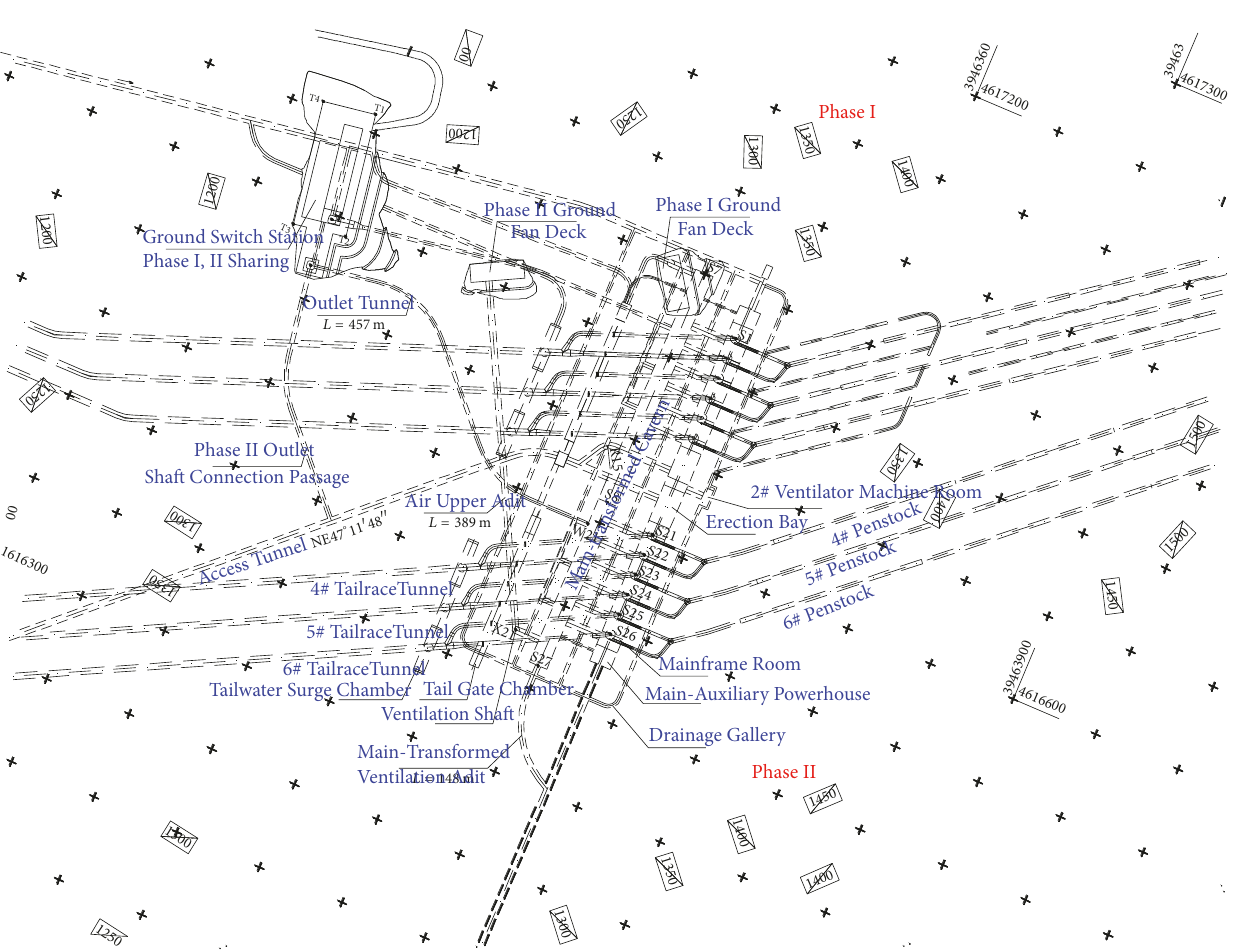
Figure 1: Layout plan for underground powerhouses of two phases of